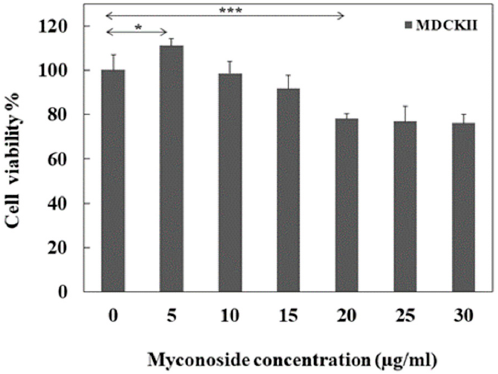
Figure 1. Cell viability after 24 h treatment of MDCKII cell line with myconoside. Data are presented as % viability compared to the untreated cells and as means ± SEM of 3 independent experiments. * p < 0.05 and *** p < 0.001 are presented as follows *, ***.